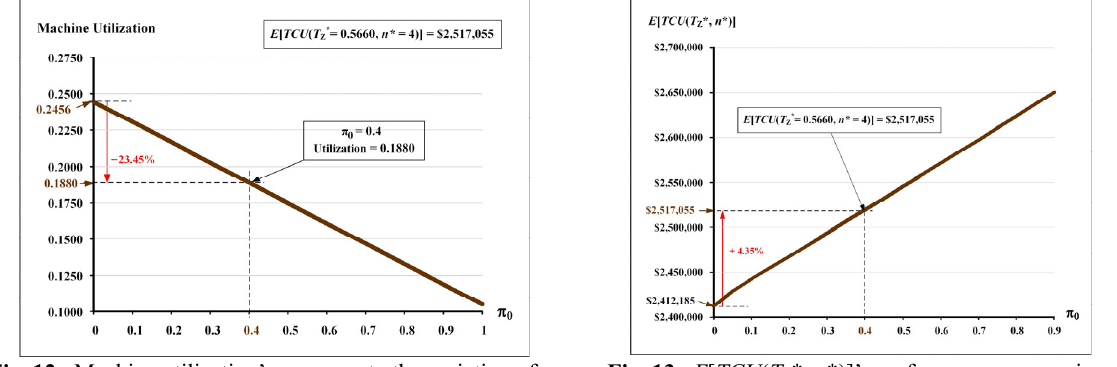
Fig. 12. Machine utilization’s response to the variation of π 0 Fig. 13. E [ TCU ( T Z *, n *)]’s performance concerning π 0